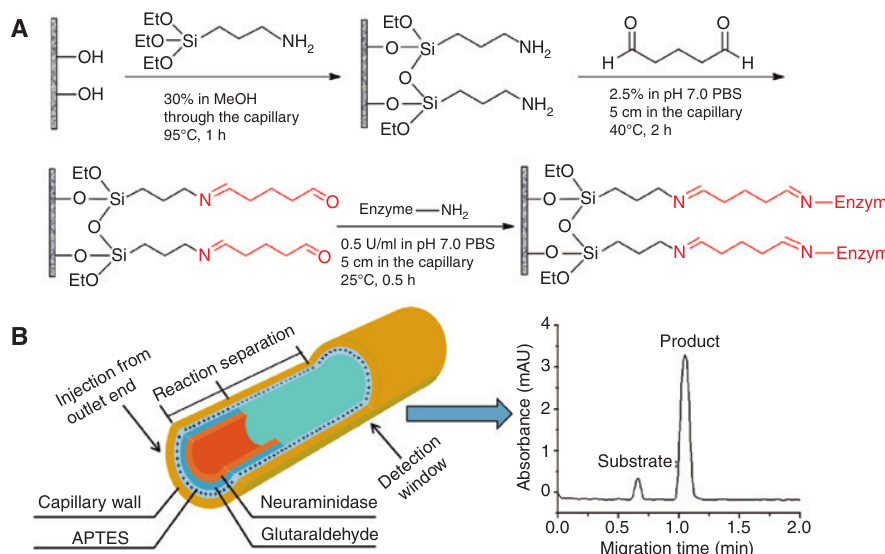
Figure 3: Procedure for immobilizing NA on capillary inner wall (A) and schematic diagram of on-line enzyme assay (B). This image was reprinted from Zhao and Chen (2014) with permission from